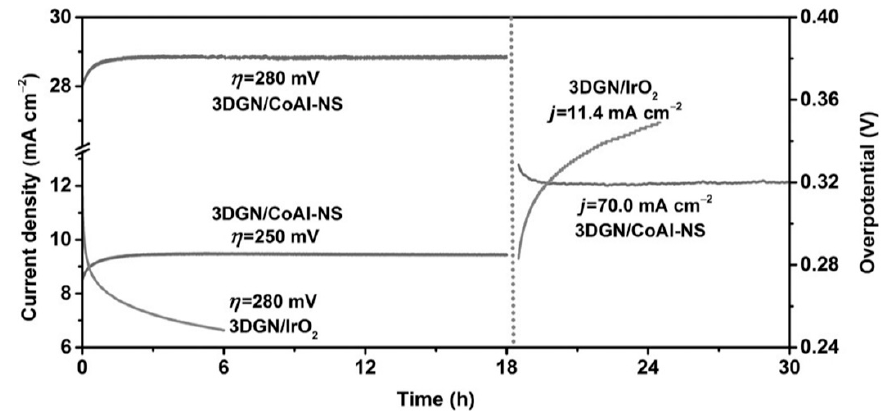
Figure 7. 3D graphene assisted formation of the porous electrocatalyst 3DGN/CoAl-NS. Reproduced Figure 7 . 3D graphene assisted formation of the porous electrocatalyst 3DGN/CoAl ‐ NS. Reproduced from [33], with permission from John Wiley and Sons, copyright 2016. from [33], with permission from John Wiley and Sons, copyright 2016.